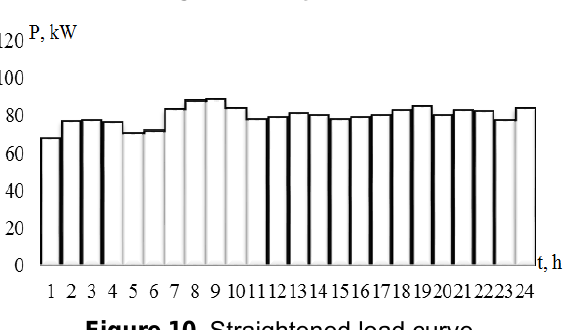
Figure 10. Straightened load